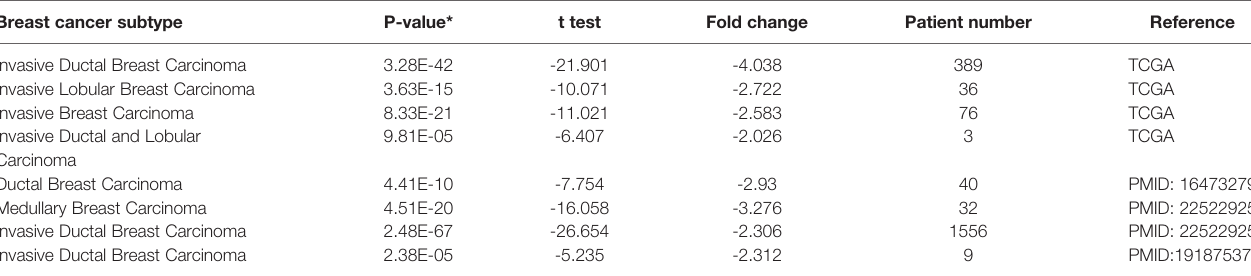
TABLE 1 | CRIM1 expression in different subtypes of breast cancer and normal tissues using the Oncomine database. Breast cancer subtype